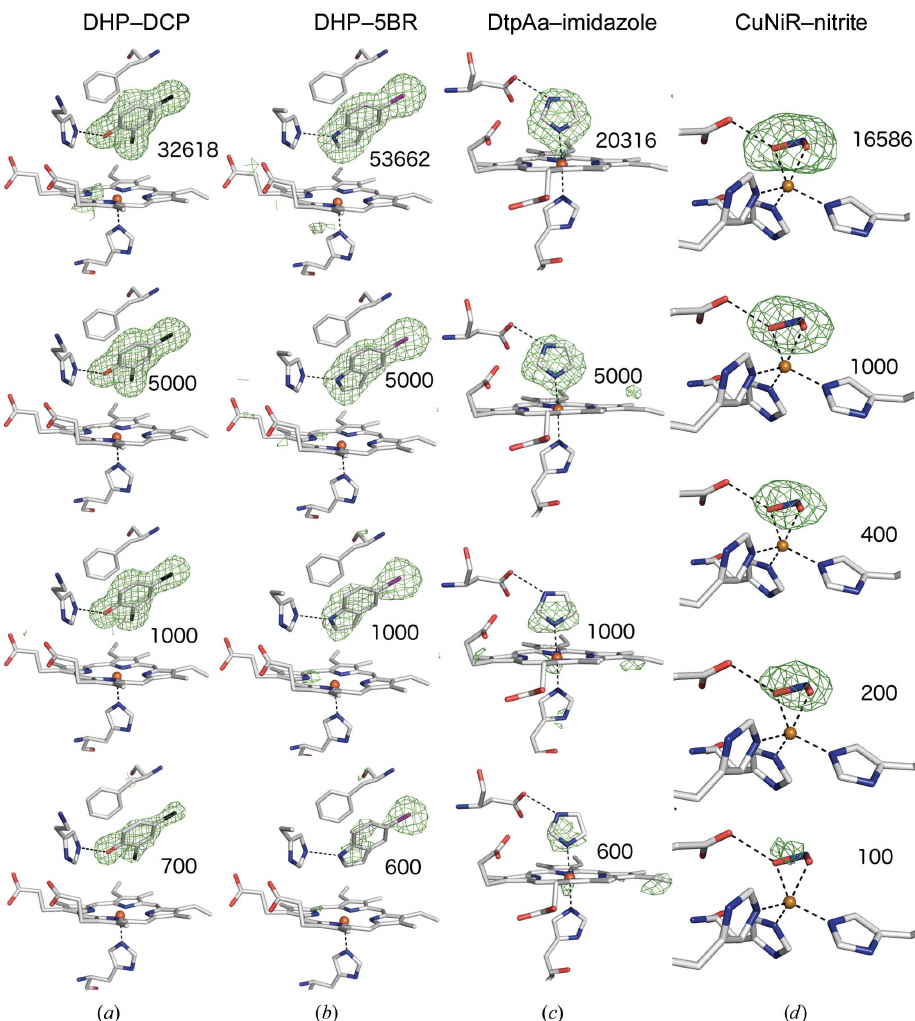
Figure 2 F o (cid:3) F c simulated-annealing OMIT maps contoured at 3 (cid:5) for the heme region from selected data subsets for ( a ) DHP–DCP, ( b ) DHP–5BR, ( c ) DtpAa–imidazole and ( d ) Ac NiR–nitrite, each superposed on the refined structure from all data. For ( a ) and ( b ) the highest occupancy ligand monomer of the homodimer